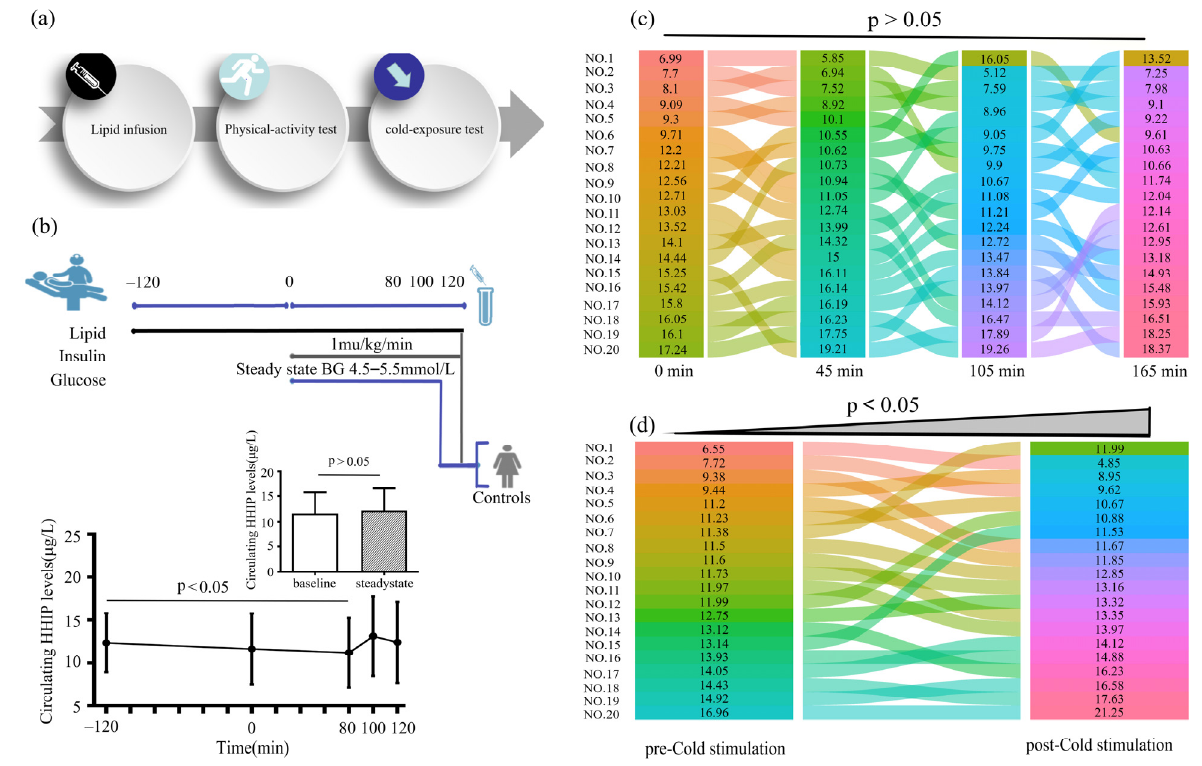
Figure 5. Circulating HHIP levels PCOS women or healthy controls during the intervention studies. ( a ) Intervention experimental procedure. ( b ) Experimental design for lipid infusion and EHC (upper panel), and changes in circulating HHIP levels during lipid infusion in healthy subjects (below panel). ( c ) Changes in circulating HHIP levels before and after exercise experiments in normal individuals. ( d ) Changes in circulating HHIP levels before and after cold-exposure experiments in normal individuals. Data are expressed as mean ± SD.